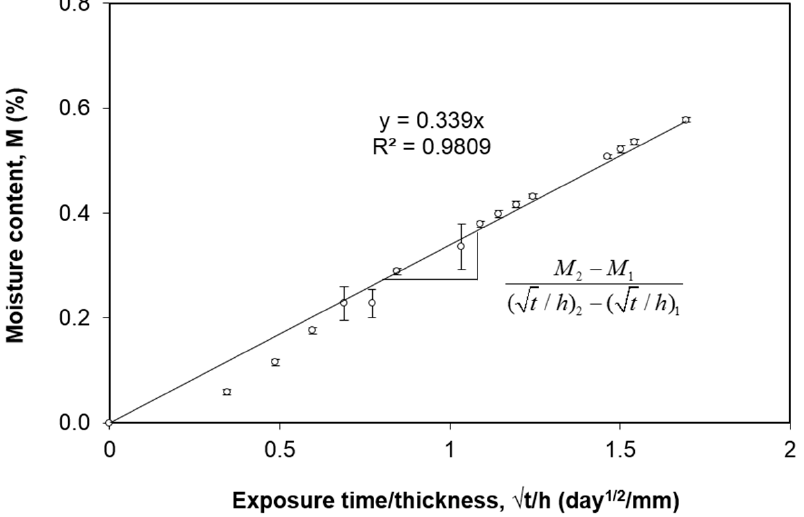
Figure 3. Initial linear region of the moisture content graph.